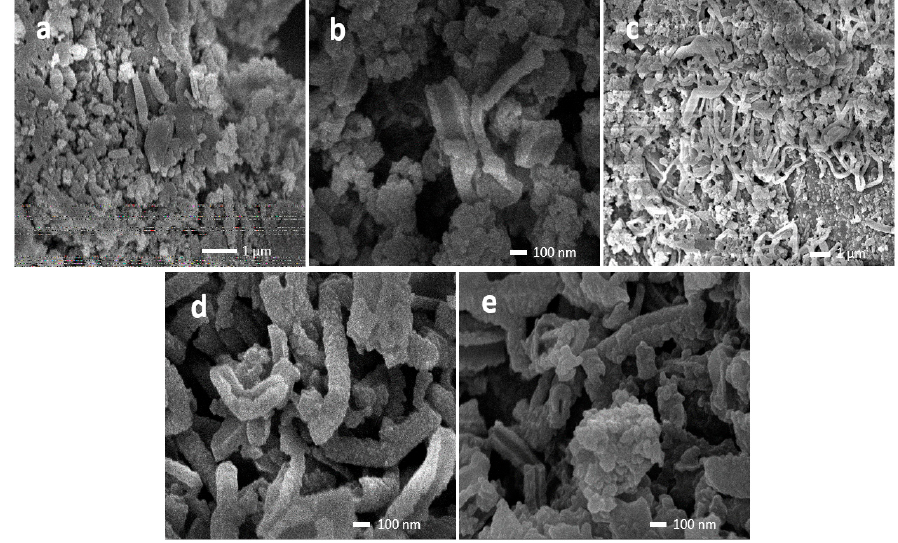
Figure 5. FESEM micrographs of PAni/MCC/CTAB nanocomposite prepared from different concentration of CTAB ( a ) 4 cmc; ( b ) 6 cmc; ( c ) 8 cmc; ( d ) 10 cmc; ( e ) 12 cmc.